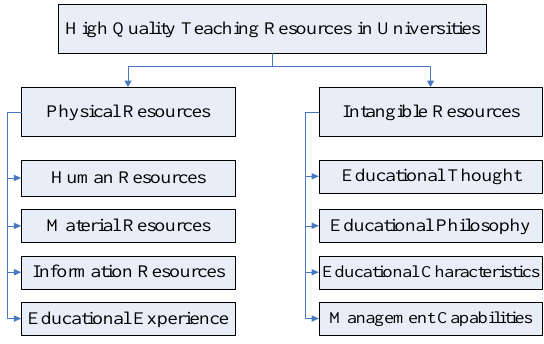
Figure 1. The classification of high quality teaching resources in